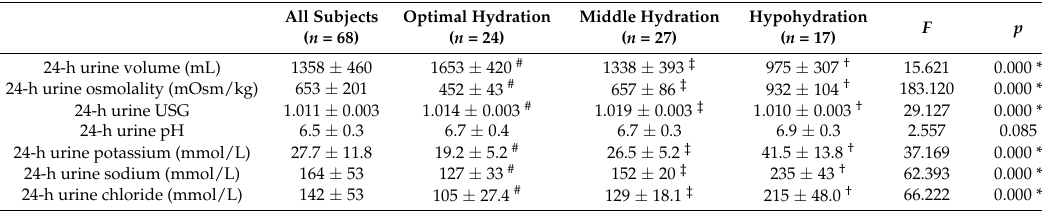
Table 4. Urine biomarkers of subjects with three hydration statuses.